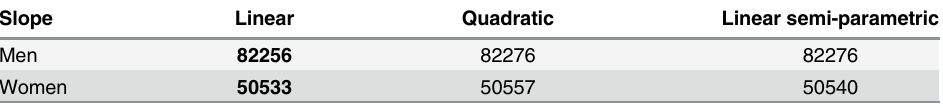
Table 3. Model fit (BIC) of three specifications of the slope for the latent growth model of grip